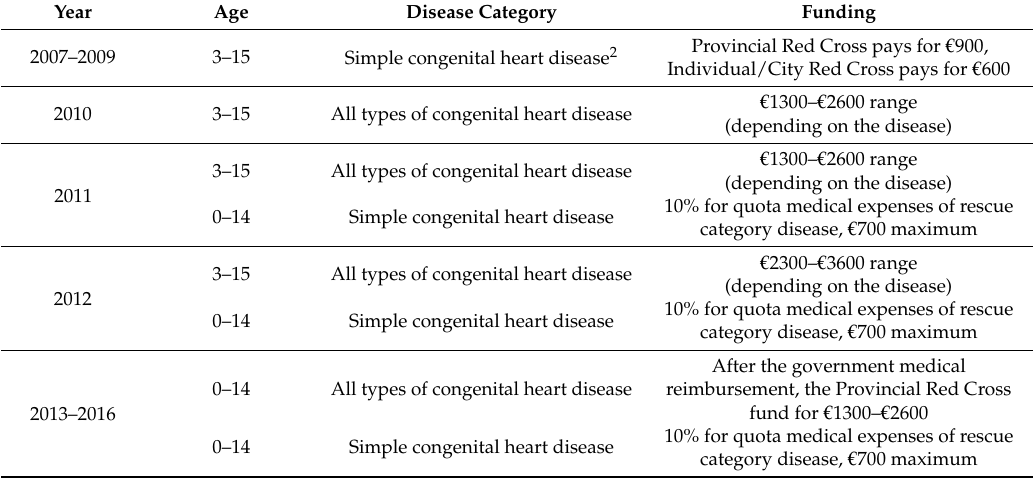
Table 1. Rescue funding of poor children with congenital heart disease relief